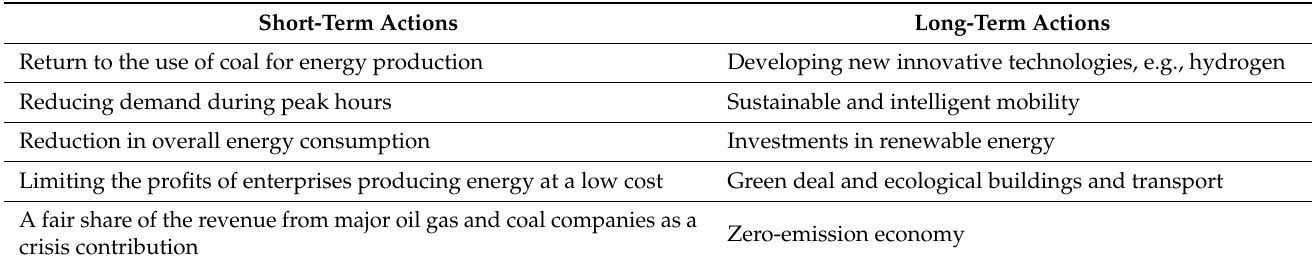
Table 3. Short- and long-term actions of the European Union in the field of energy security and climate